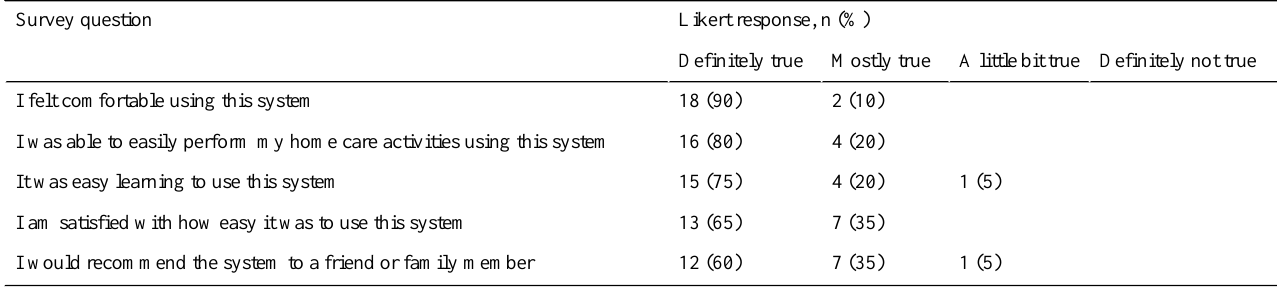
Table 3. Overall usability and satisfaction with the intervention as reported by study participants (N=20).